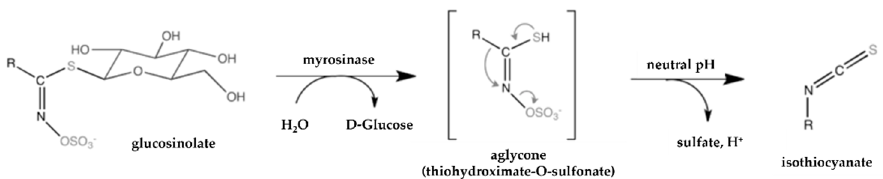
Figure 2. Mechanism of hydrolysis of a glucosinolate by myrosinase, originating isothiocyanates in neutral pH [71].